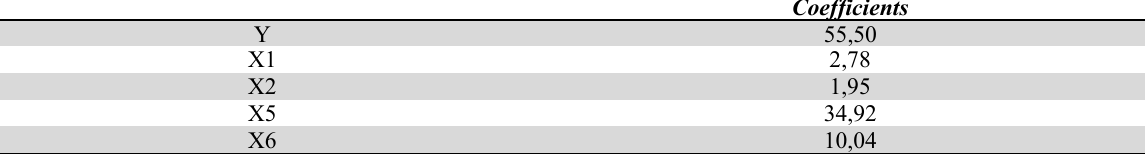
Correlation and regression analysis of dominant